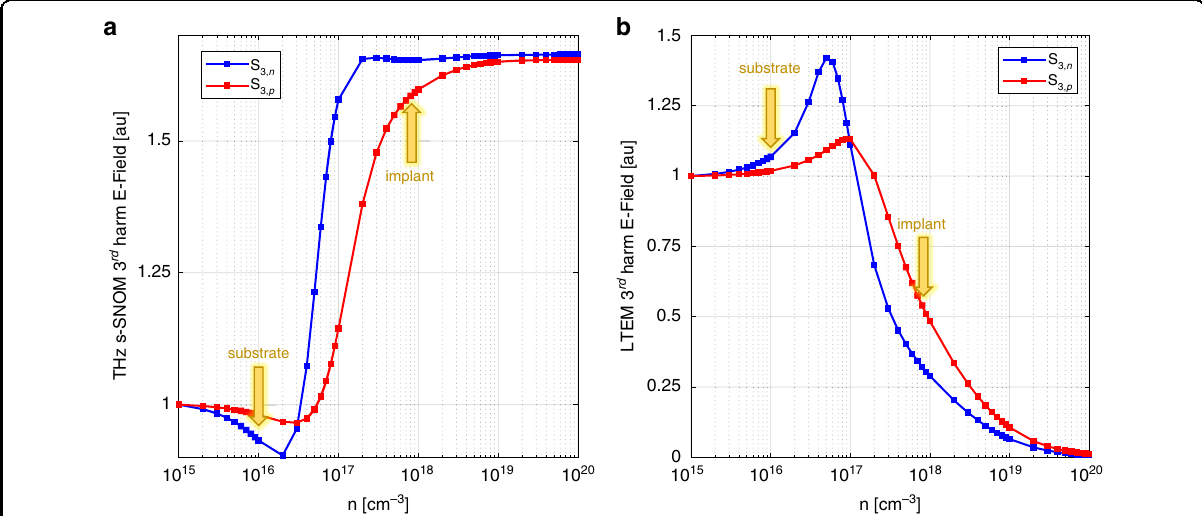
Fig. 6 FDM and LTEM FDM predictions of THz near- fi eld signal as a function of Si doping concentration. a FDM simulation of the 3rd harmonic THz s-SNOM signal at 0.84 THz vs. local Si carrier concentration, for increasing n doping (blue) and increasing p doping (red). b FDM simulation of 3rd harmonic LTEM signal at 0.84 THz from Si, as n doping increases (blue) and p doping increases (red). Speci fi ed substrate doping is marked with a yellow arrow as “ substrate ” , and each model ’ s predicted implant doping is marked by a yellow arrow labeled “ implant ” . Both models predict an approximate implant doping of 8 × 10 17 cm −